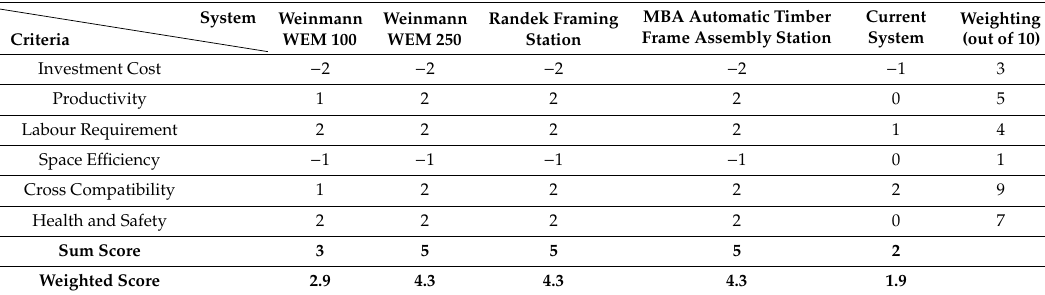
Table 6. Resultant scores for framing and stud fitting.